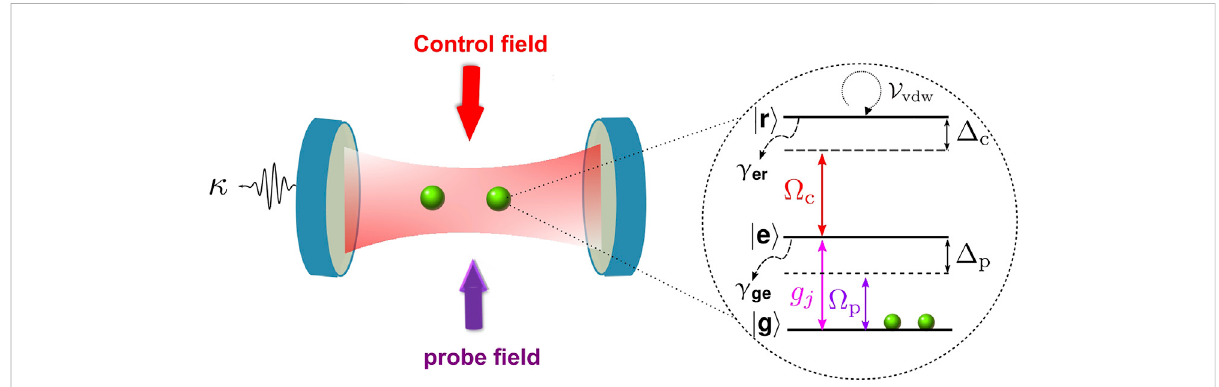
FIGURE 1 (Coloronline)Schematicdiagramofasingle-modecavitycoupledwithtwothree-levelladder-typeatoms.Levels| g 〉 and| e 〉 arecoupledtothe cavity fi eld with the coupling strength g j . Moreover, the control fi eld of frequency ω c with Rabi frequency Ω C couples the transition | e 〉 to | r 〉 and a probe fi eldwith frequency ω p andstrength Ω p coupledthestate | g 〉 and| e 〉 ,respectively. γ er and γ ge arethespontaneousemission ratesfromstates | r 〉 and | e 〉 , respectively, and κ is the cavity decay. The two-atom system with Van der Waals potential between the Rydberg states creates an interaction V vdw dependent on the atom